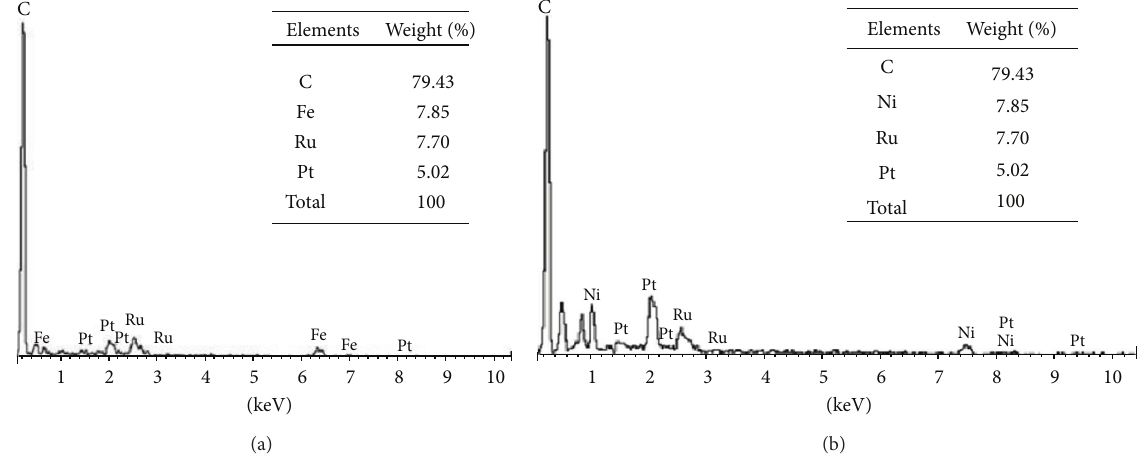
Figure 2: EDX results for MWCNT-based nanocatalyst with the addition of (a) iron and (b) nickel.